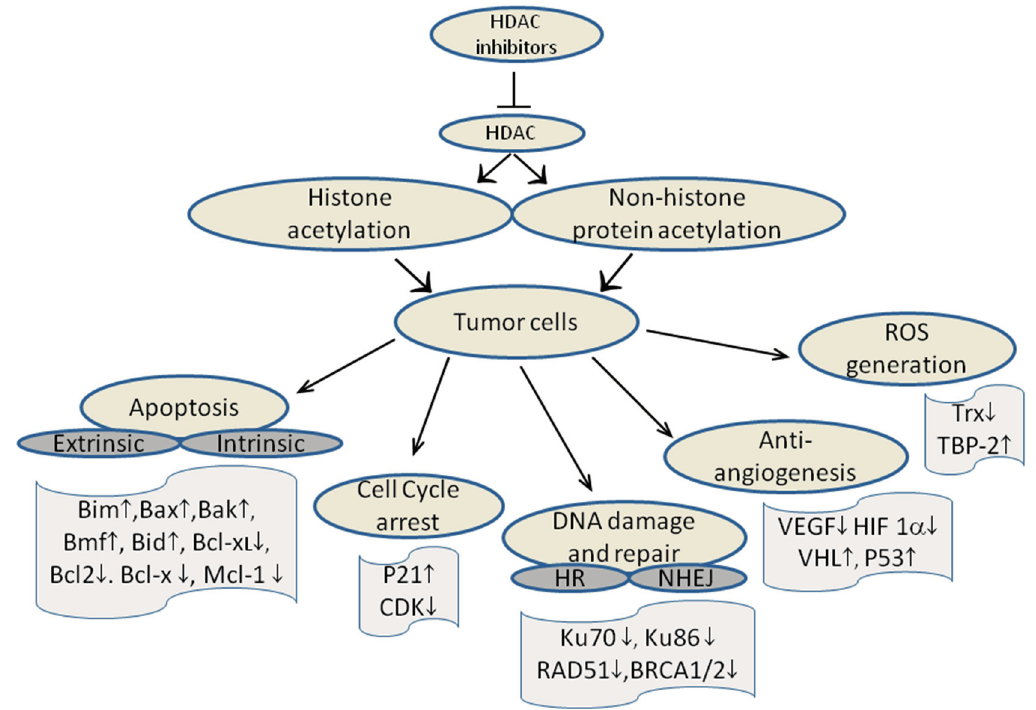
Figure 4. Multiple anti-tumor pathways activated by HDACi. Extrinsic and intrinsic refer to two apoptosis pathways, and HR and NHEJ refer to two DBS repair